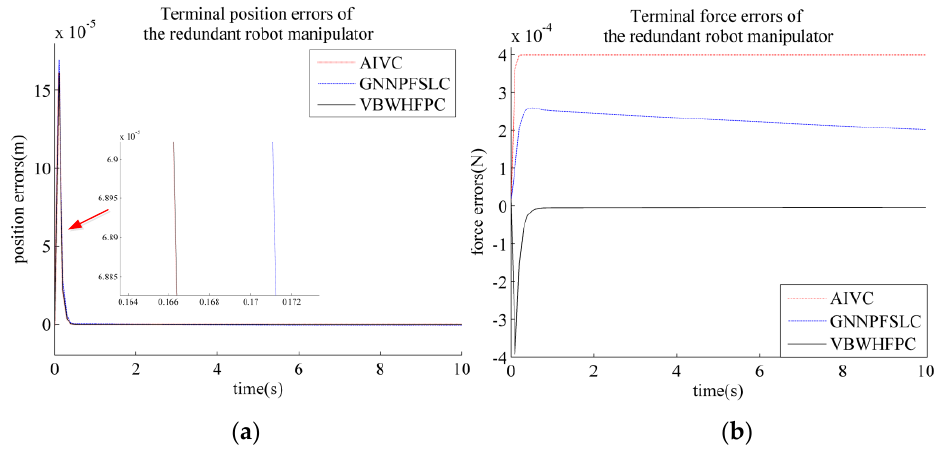
Figure 4. Control accuracy of the above three algorithms ( a ) position control in the Y-axis direction; ( b ) force control in the X-axis direction. Table 2. Position and force accuracies during the wiping operation.